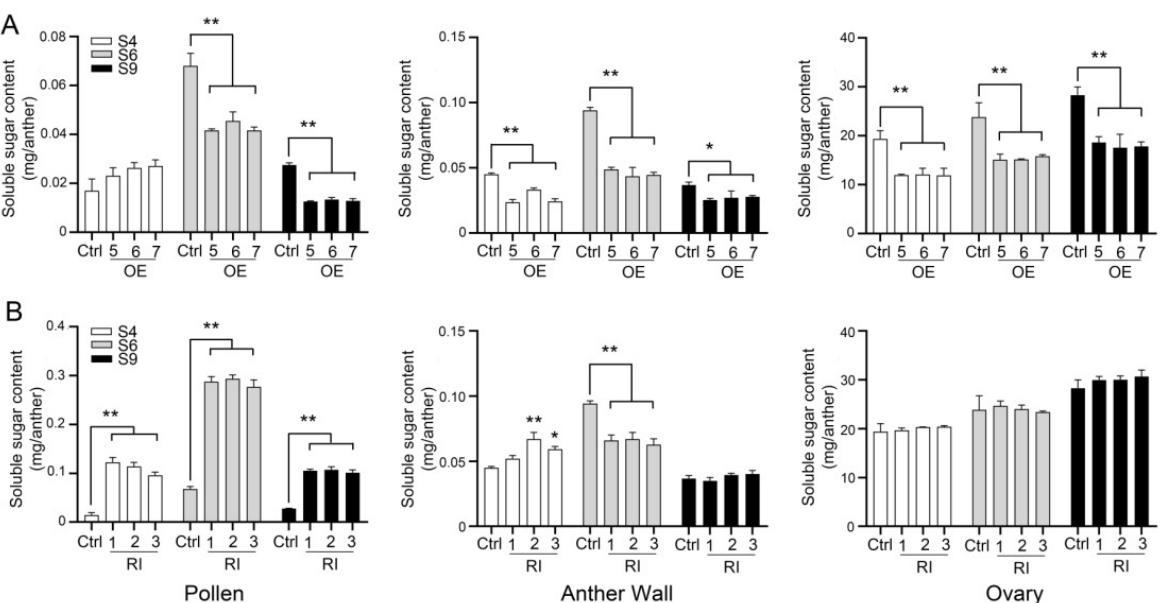
Figure 5. Analyses of the content of total soluble sugar at the indicated stages of floral development. The content of total soluble sugar in the pollen grains, anther walls and ovaries of NtMYC2a -OE ( A ), NtMYC2a -RI ( B ) and control plants were examined. Results are shown as means ± SD, n = 10, significant differences from the data of control plants are indicated: * p < 0.05, ** p < 0.01 (Student’s t -test).